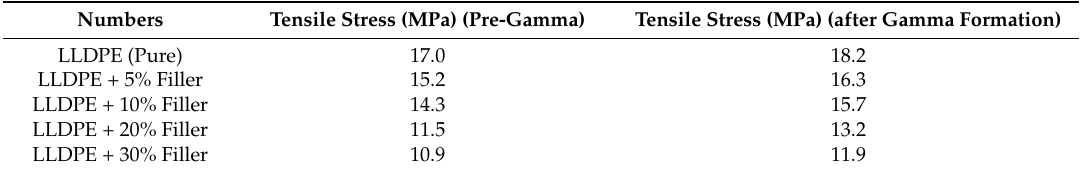
Table 3. Comparative presentation of tensile stress results for polyethylene matrix specimens before and after